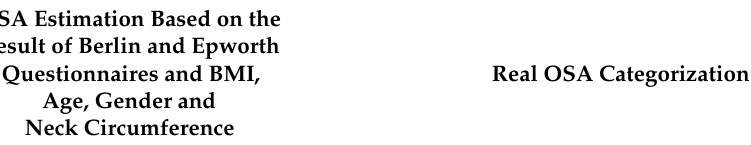
Table 13. AI prediction of OSA based on age, gender, BMI, neck circumference and data from the Berlin and Epworth questionnaires (the table shows the number of cases per 100 patients and the percentage distribution of scores within OSA categories). OSA: obstructive sleep